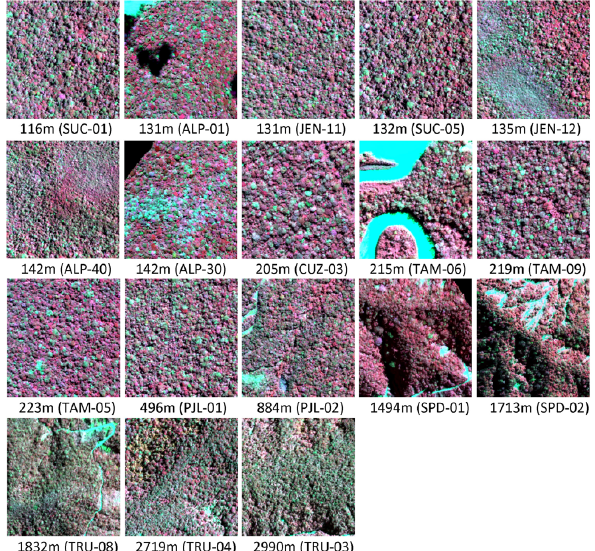
Fig. 8. Changes in narrowband, near-infrared reflectance spec- troscopy of forests along the elevation gradient. Images are a combi- nation of near-infrared (800–809nm), red (650–659nm), and green (550–559nm) reflectance. Black areas are image edges, cloud shad- ows (ALP-01), and/or topographic shade (SPD-01/02).